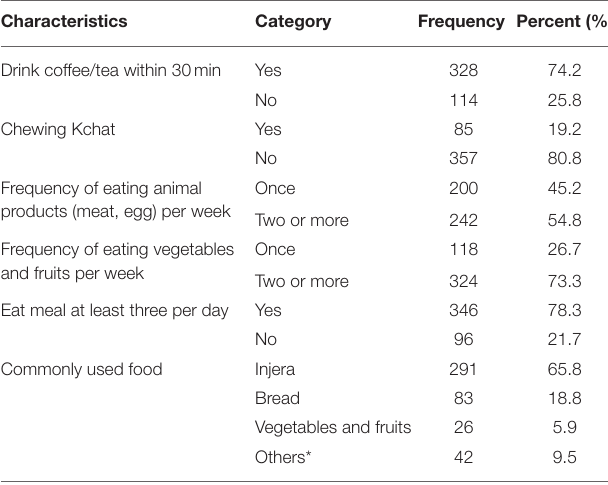
TABLE 4 | Dietary intake characteristics of respondents attending ANC in a University hospital in Eastern Ethiopia, 2021 ( n =